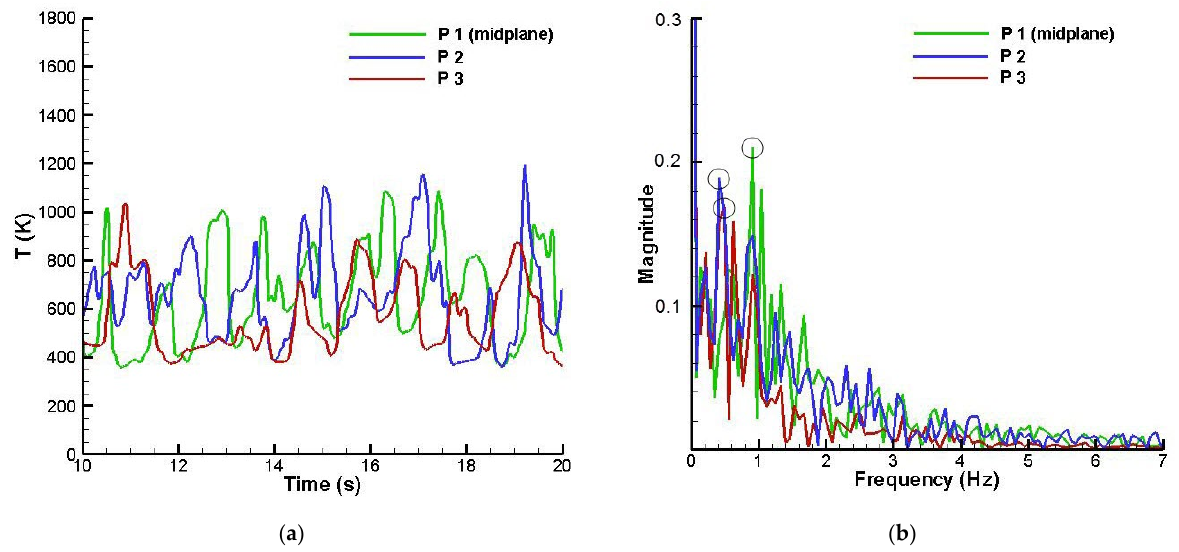
Figure 6. ( a ) Time history of instantaneous surface temperature; ( b ) frequency spectrum of temperature obtained from fast Fourier transform (FFT) analysis; dominant frequencies are marked with circles.